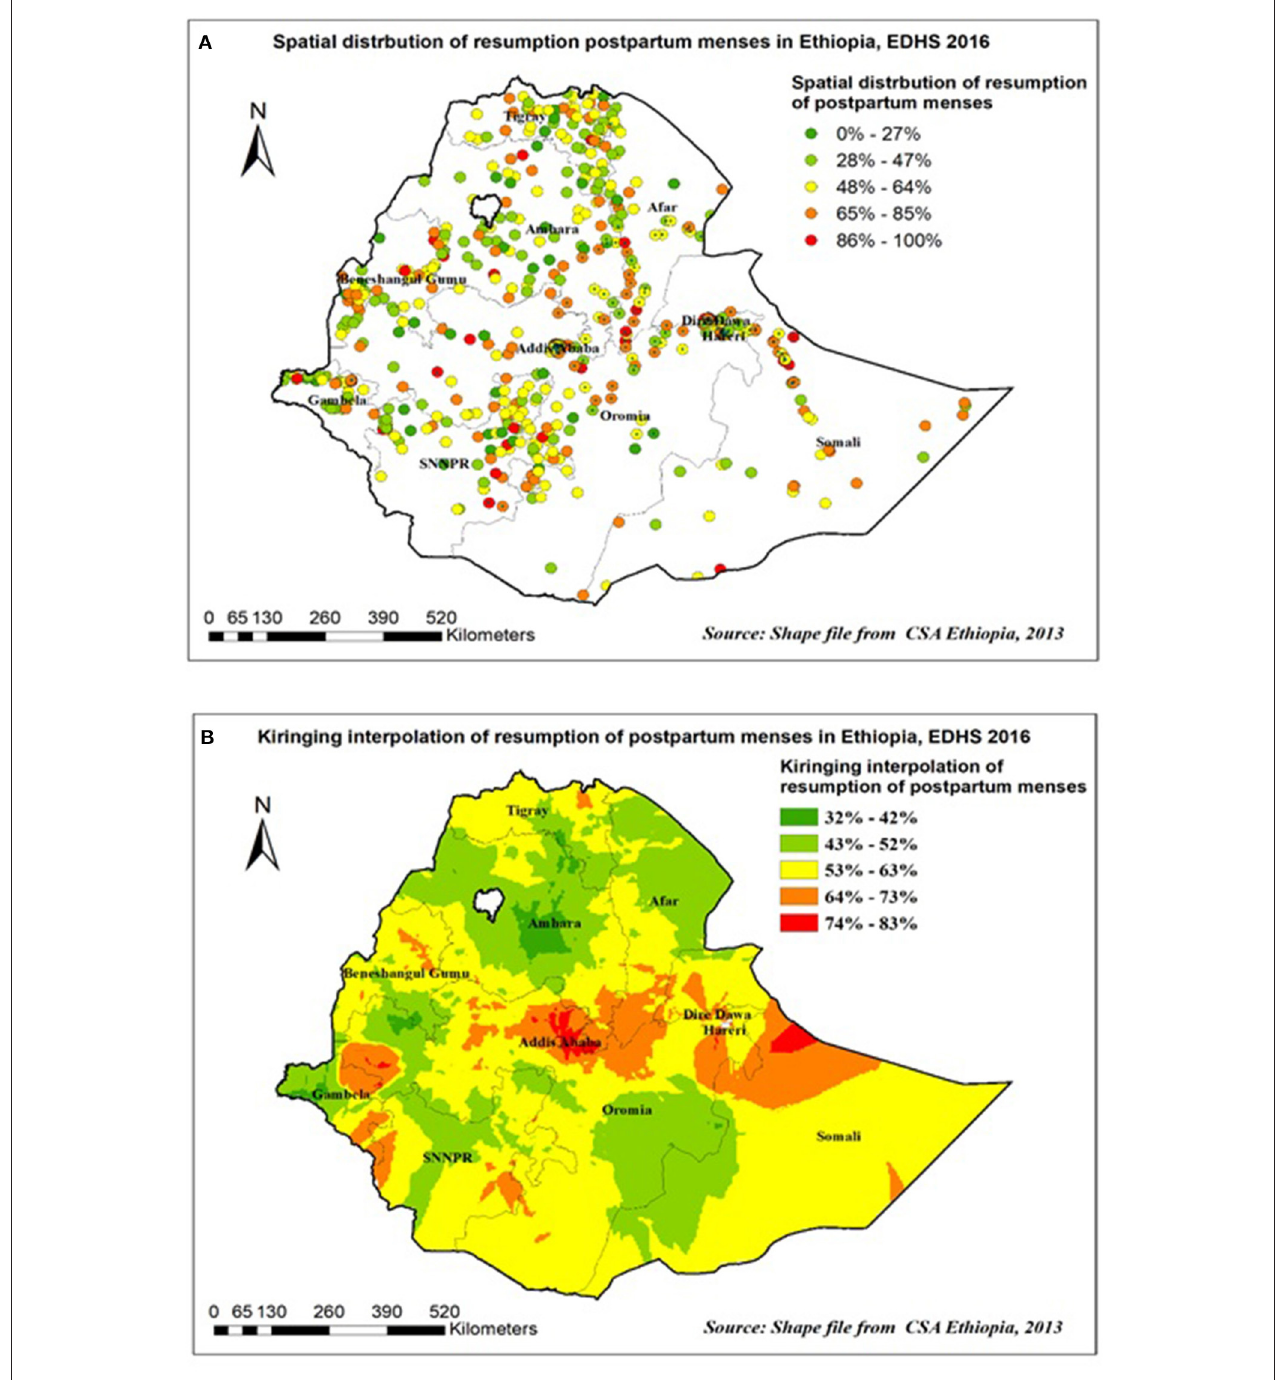
FIGURE 3 | Spatial distribution (A) and interpolation (B) of resumption of postpartum menses in Ethiopia EDHS 2016.